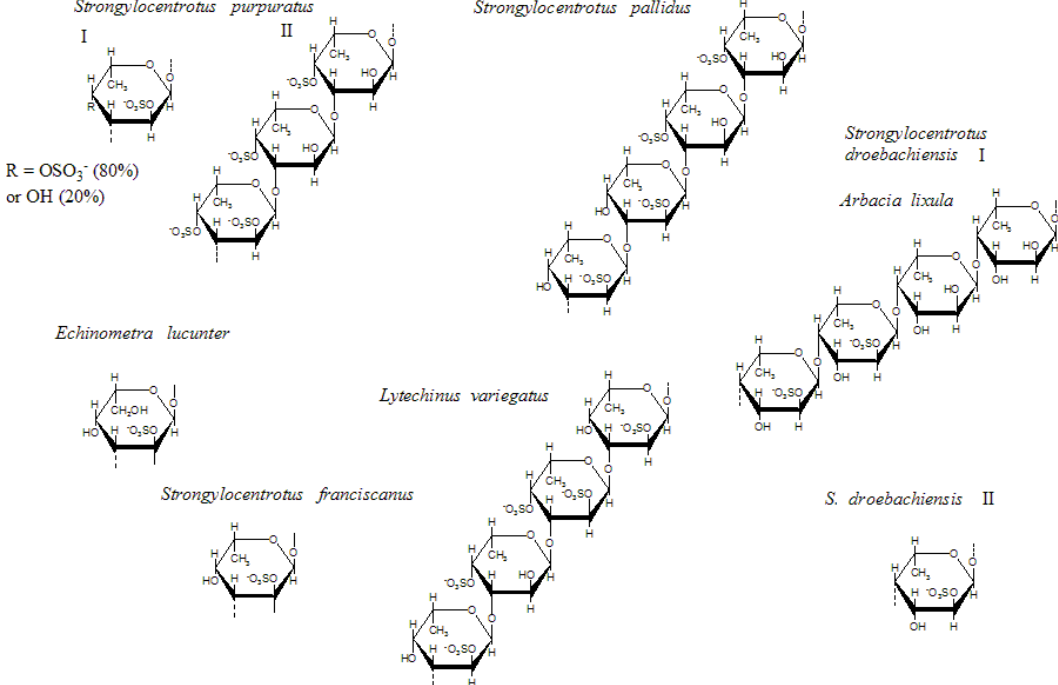
Fig. 4 – Structures of sea urchin egg-jelly fucans, important for species-specificity in fertilization. Unlike plant fucoidans, these linear polymers of α -L-fucose have absolutely regular structures. Each has a single linkage type, with a characteristic pattern of sulfate substitution giving rise to a repeat unit of 1 to 4 monosaccharide residues. The species S. franciscanus has a 3- linked, 2-sulfated homopolymeric fucan, whereas S. pallidus and L. variegatus have 3-linked fucans in which patterns of sulfate substitution define a tetrasaccharide repeat. Species specificity of the fucans is not always simple: there are two populations of S. purpuratus with differing 3- linked fucan structures and two populations of S. droebachiensis with differing 4- linked fucans, one of which is identical with the fucan from the species A. lixula . The two species with identical egg-jelly fucans are not found in the same waters, so the potential problem of cross-fertilization does not